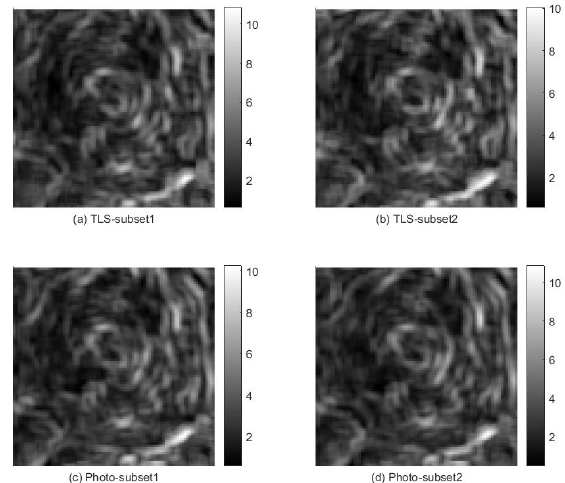
Figure 5. The standard deviation of slope for the window size of 76 mm (i.e. 7 times the average data spacing).